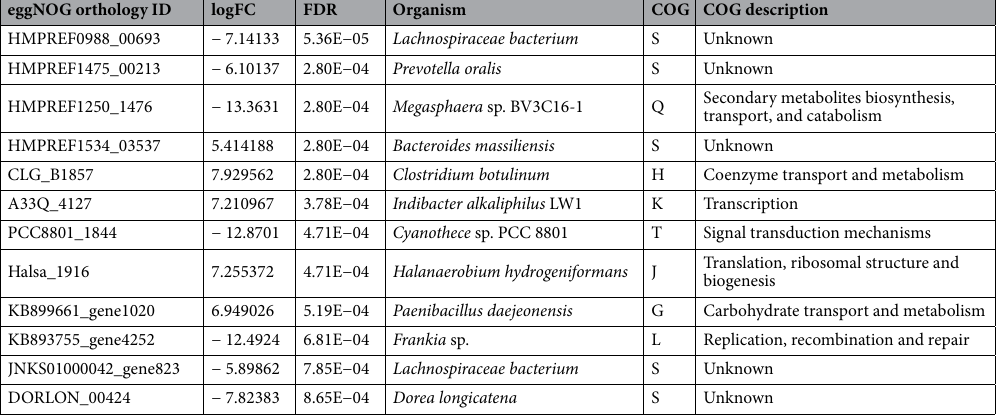
Table 2. Differentially abundant genes from protein-level